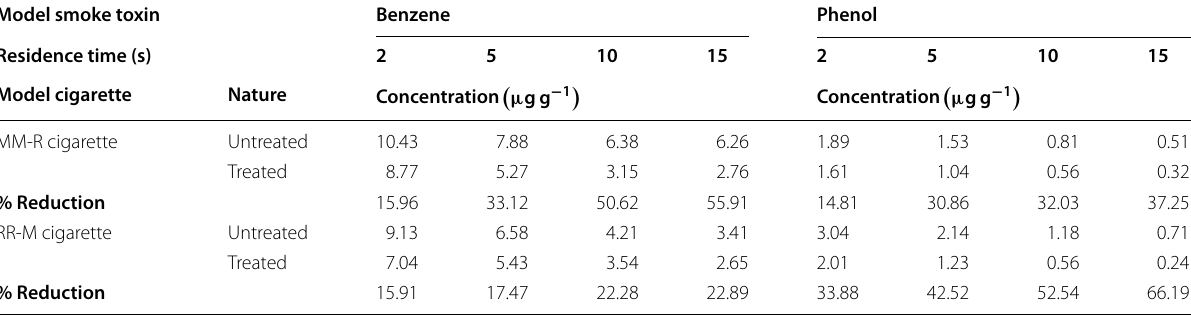
Bold values defined % Reduction of model tobacco chemical MM-R standard cigarette, RR-M local cigarette